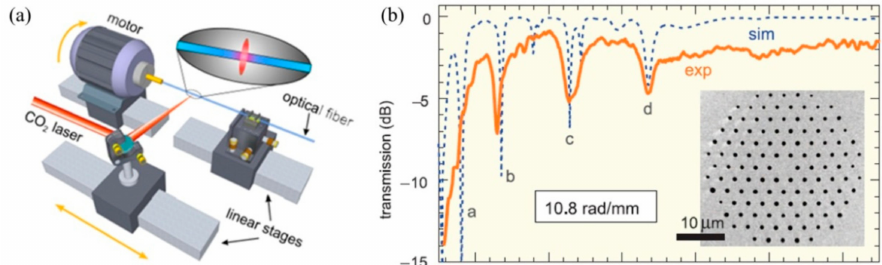
Figure 9. ( a ) Experimental setup for fabricating the HLPFG in PCF by use of CO 2 laser; ( b ) the simulated and measured transmission spectrum of HLPFG in PCF